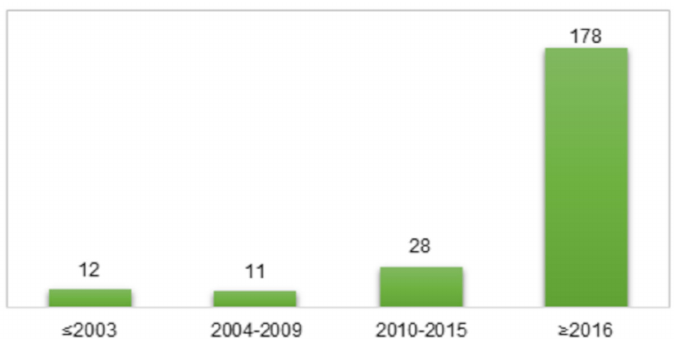
Figure 2. Number of articles cited in this review by year of